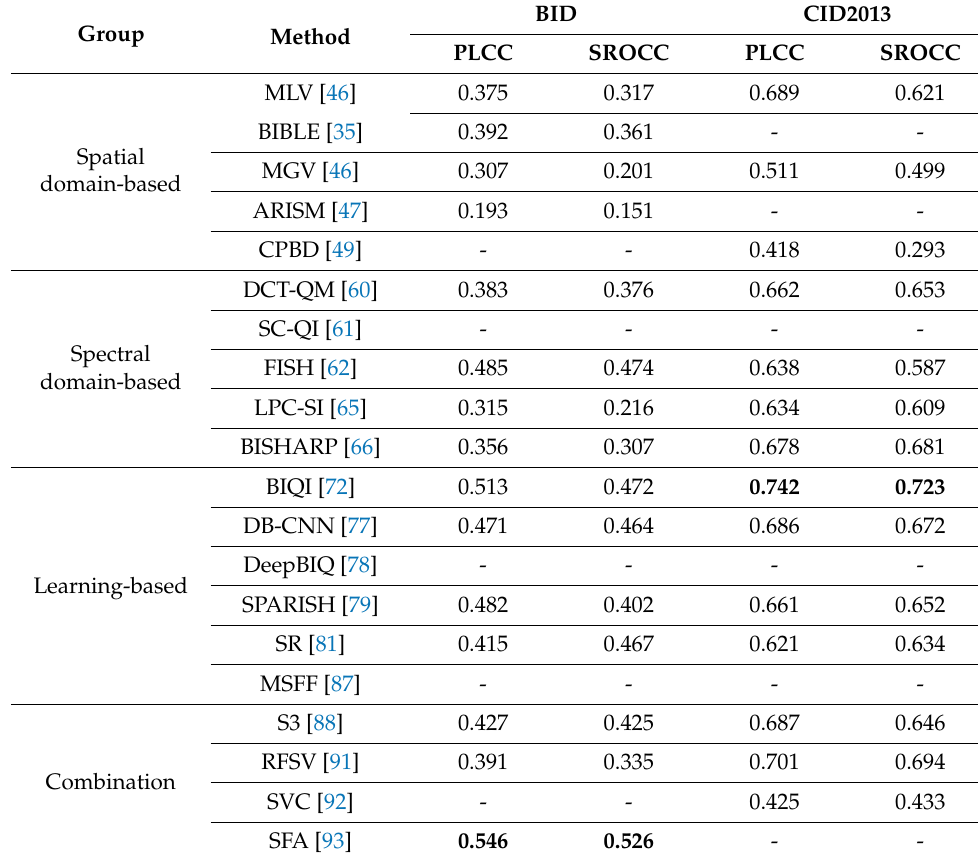
Table 7. Comparison of different evaluation methods on BID dataset and CID2013